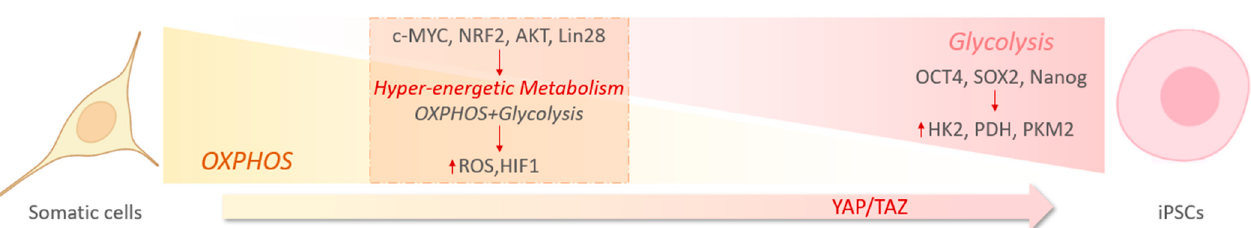
Figure 3. Cell reprogramming is accompanied by a decrease in OXPHOS and an increase in glycolysis. Shortly after reprogramming begins, cells undergo a transient hyperenergetic metabolism, which generates ROS, leading to the activation of HIF1, which further stimulates metabolic reprogramming together with c-MYC, NRF2, AKT and Lin28. A direct transcrip- tional regulation of glycolytic genes depends also on pluripotency factors OCT4, SOX2 and Nanog. YAP/TAZ activation may regulate the switch from OXPHOS to glycolysis in cell reprogramming, promoting glucose uptake and utilization, enhancing glutaminolysis, regulating the expression of metabolic genes, affecting epigenetic modifications to chromatin structure and post-transcriptional miRNA processing. Red arrows before ROS and HK2 mean “increased See the text for abbreviations.